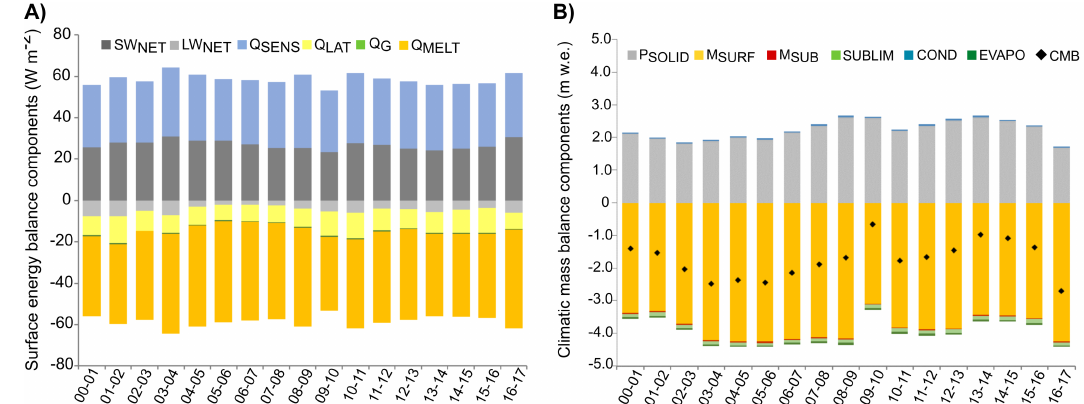
Figure 6. Annual surface energy balance components ( A ) and climatic mass balance ( B ) averaged between April 2000 and March 2017. Abbreviations are explained in Equation (1).